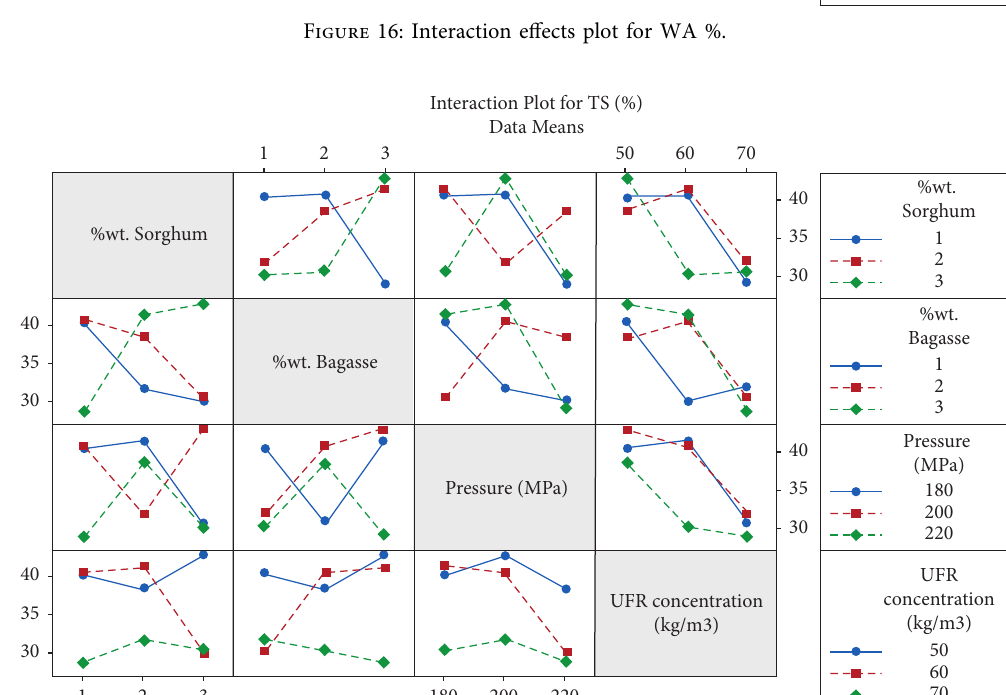
Figure 16: Interaction effects plot for WA %.